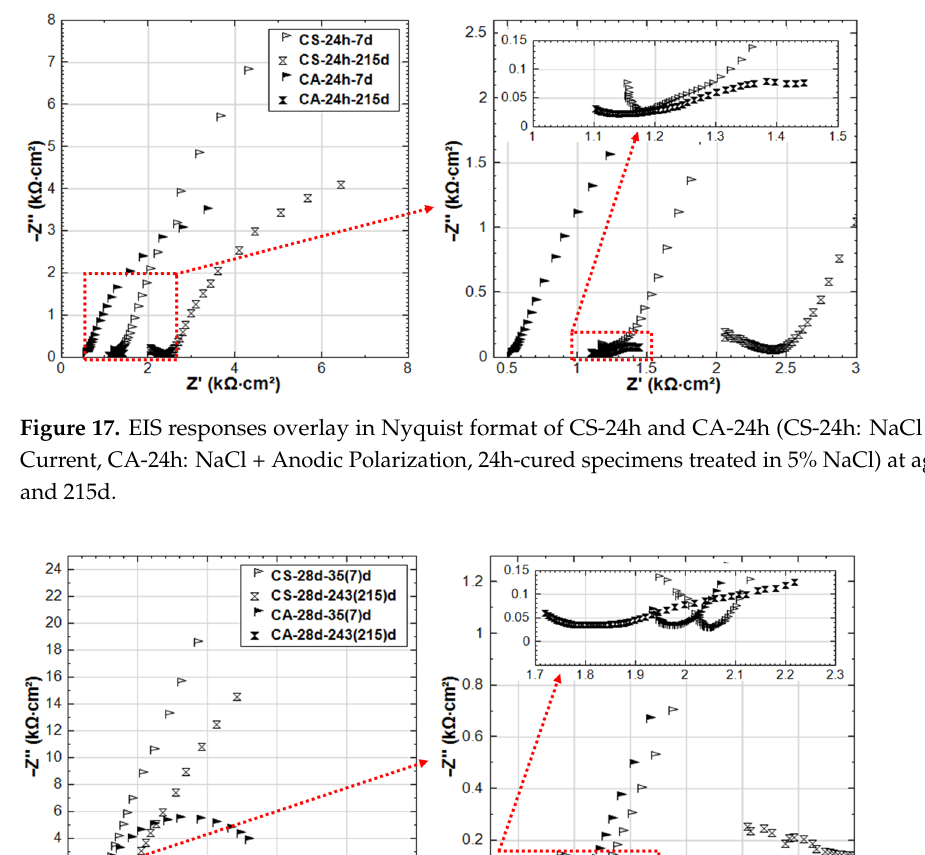
Figure 16. EIS responses overlay in Nyquist format of S-28d and A-28d (S-28d: Stray Current, A-28d: Anodic Polarization, 28d-cured specimens treated in water) at age of 35(7)d and 243(215)d.